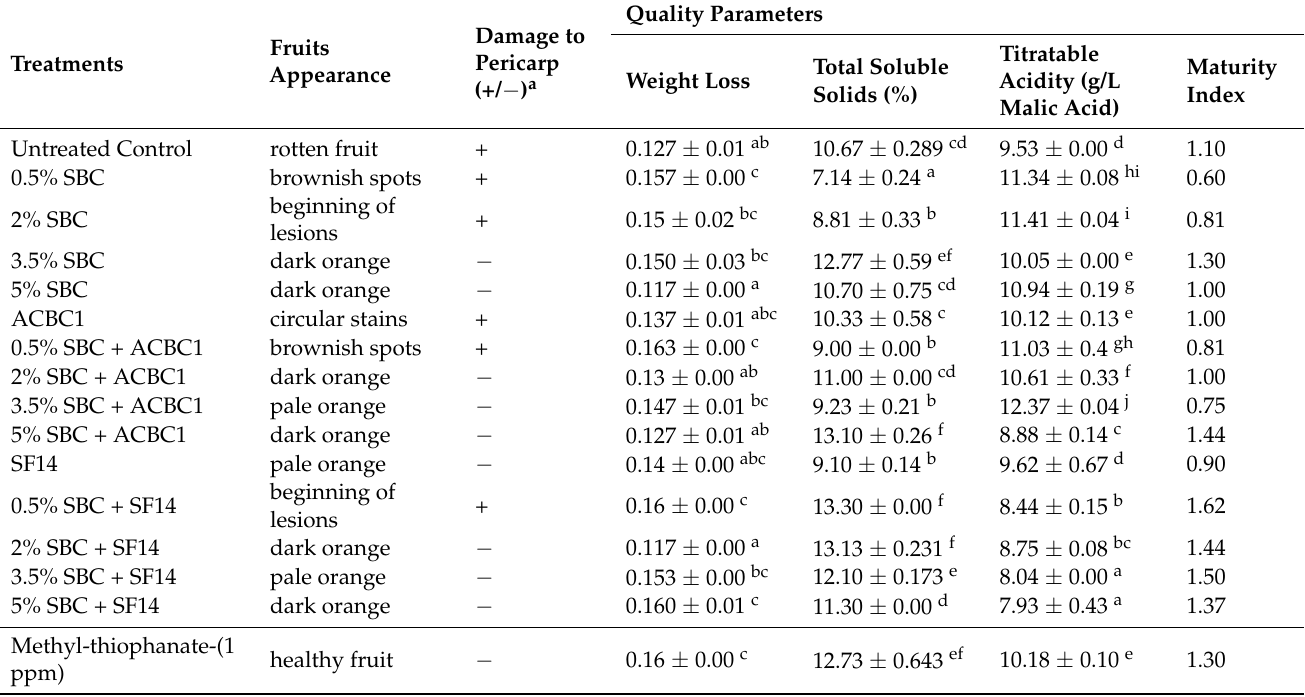
Table 4. Effect of sodium bicarbonate, antagonistic bacteria ( Bacillus amylolquefaciens SF14 and Alcaligenes faecalis ACBC1) on quality parameters of nectarine fruits artificially